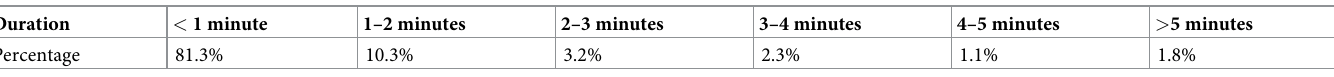
Table 2. Duration of seizure events (averaged over all